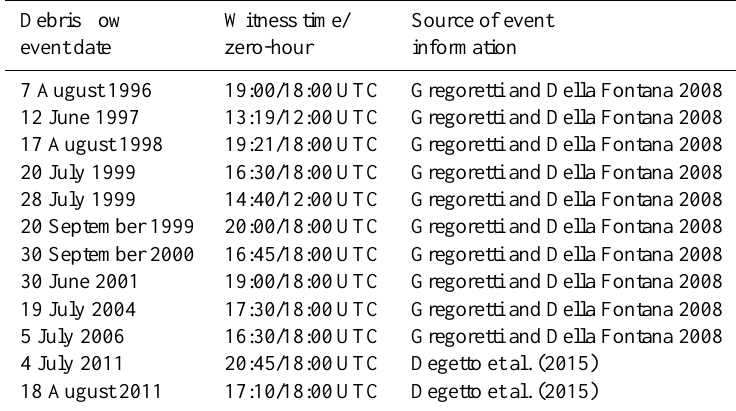
Table 1. The population of 12 debris flow events.